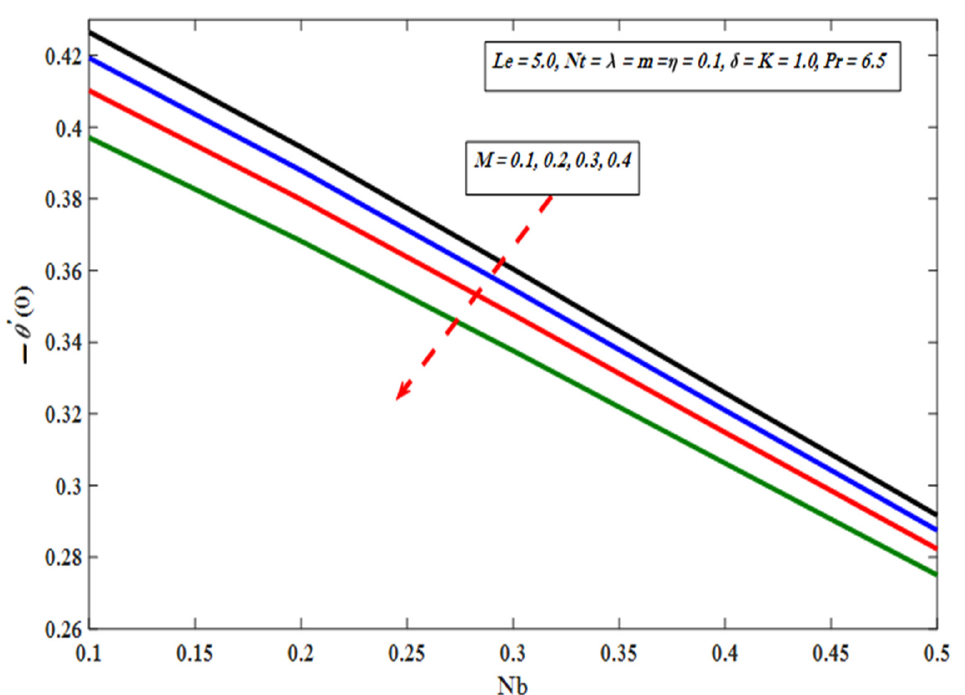
Figure 10. − θ (cid:48) ( 0 ) for various values of M and Nb Figure 10. (cid:3398)𝜃′(cid:4666)0(cid:4667) for various values of M and 𝑁𝑏.